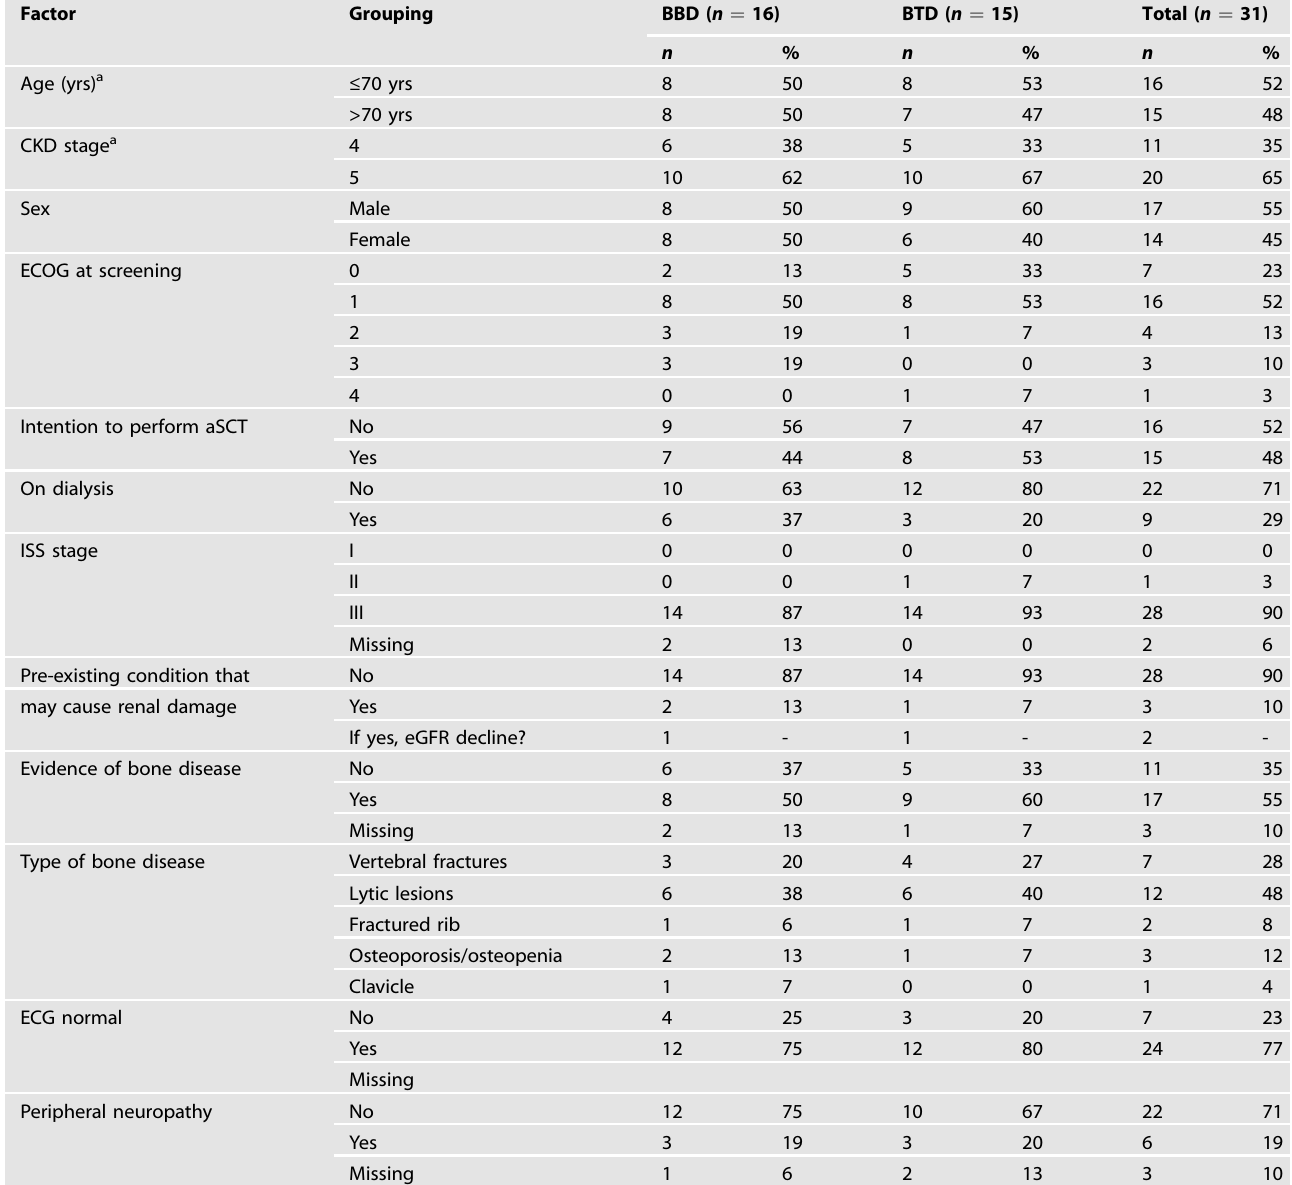
Table 1. Patient characteristics by treatment